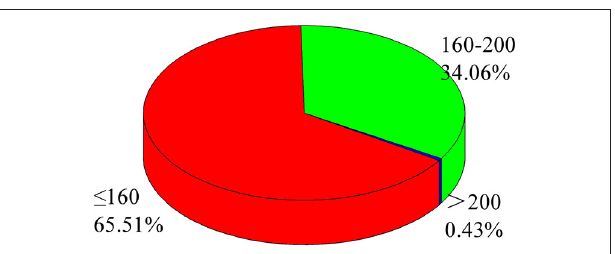
FIGURE 2 | Statistics of mental health scores for graduate students. Data source: Author